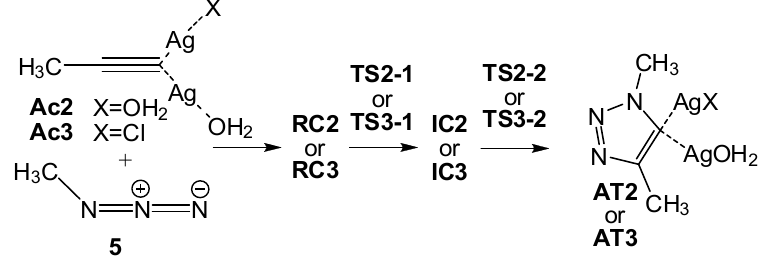
Figure 9. AgAAC reactions of the dinuclear Ac2 or Ac3 species with 5 .